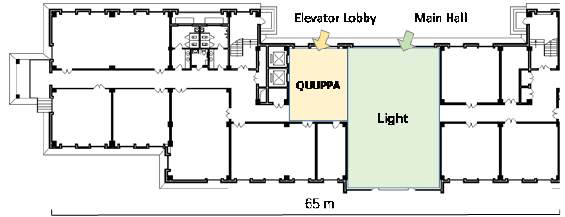
Figure 2. A typical office building equipped with acoustic, light and QUUPPA devices. The low-cost Wi-Fi is fully covered in this scenario.